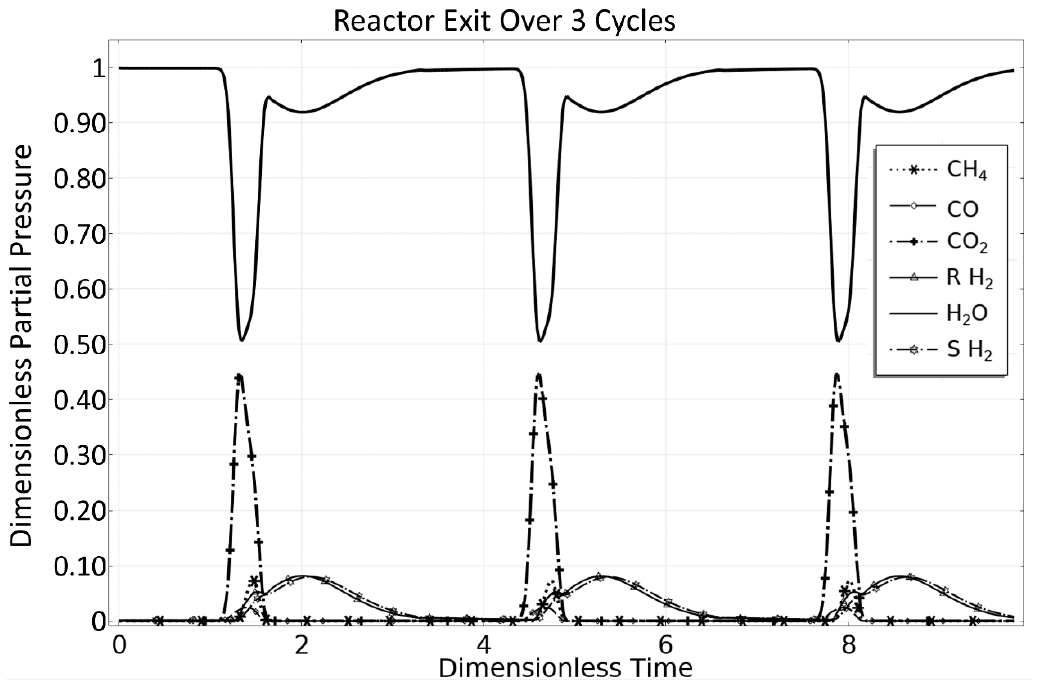
Figure 10. Dimensionless time evolution of dimensionless species’ partial pressure at reactor outlet over 3 cycles of operation for Da = 4, Θ = 50.